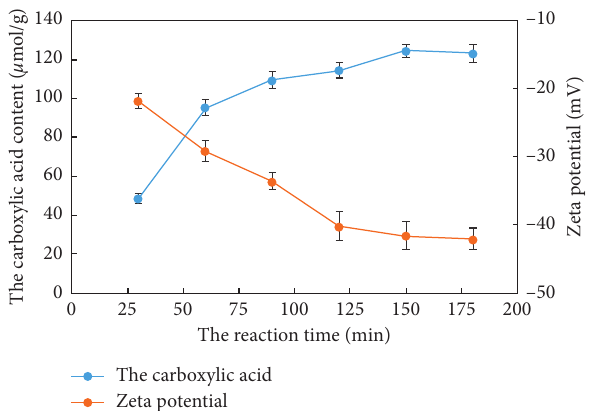
Figure 4: The effect of reaction time on the Fenton oxidation